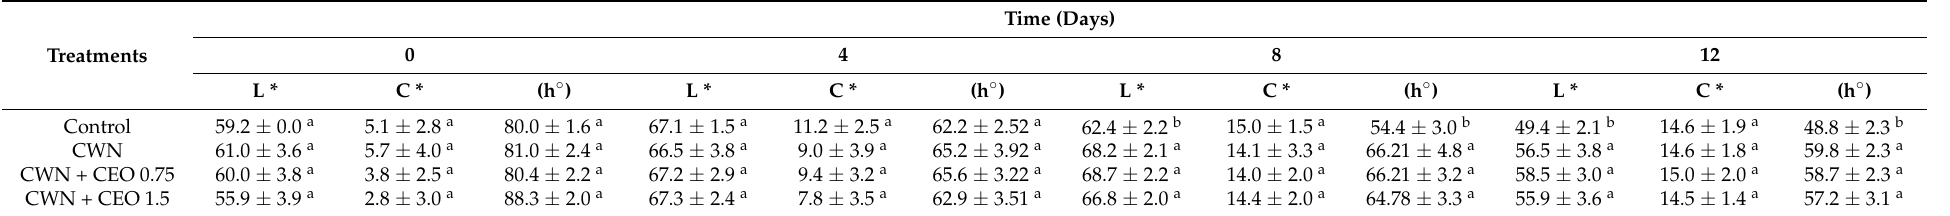
Table 2. Results of color parameters of papaya uncoated and coated during 12 days of storage (16 ± 1 ◦ C). Results are expressed as average ± standard deviation (n: